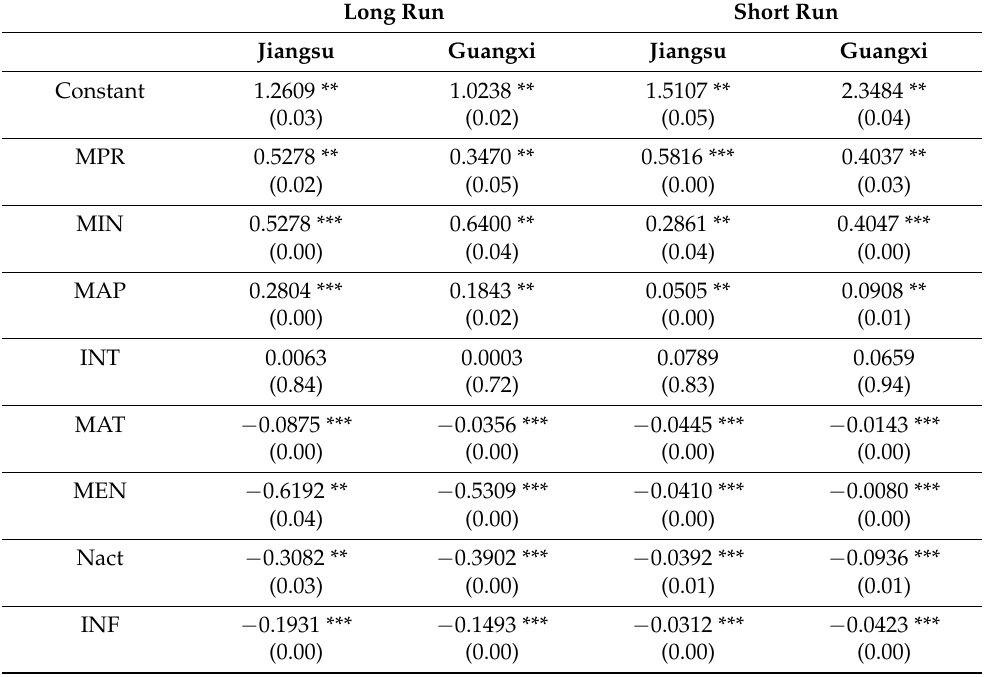
Table 5. Long- and short-run